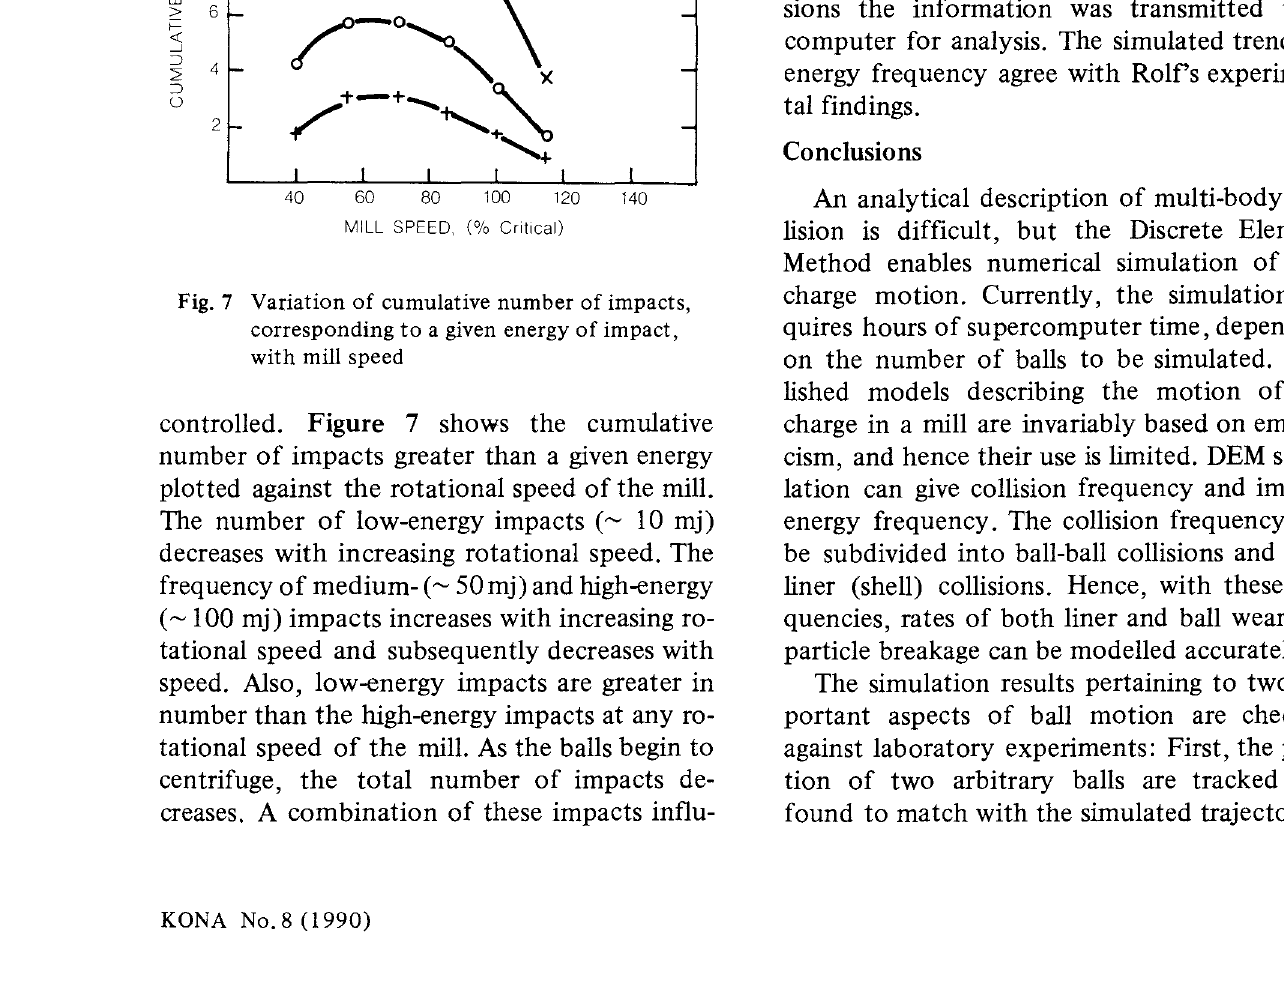
Fig. 7 Variation of cumulative number of impacts, corresponding to a given energy of impact, with mill speed